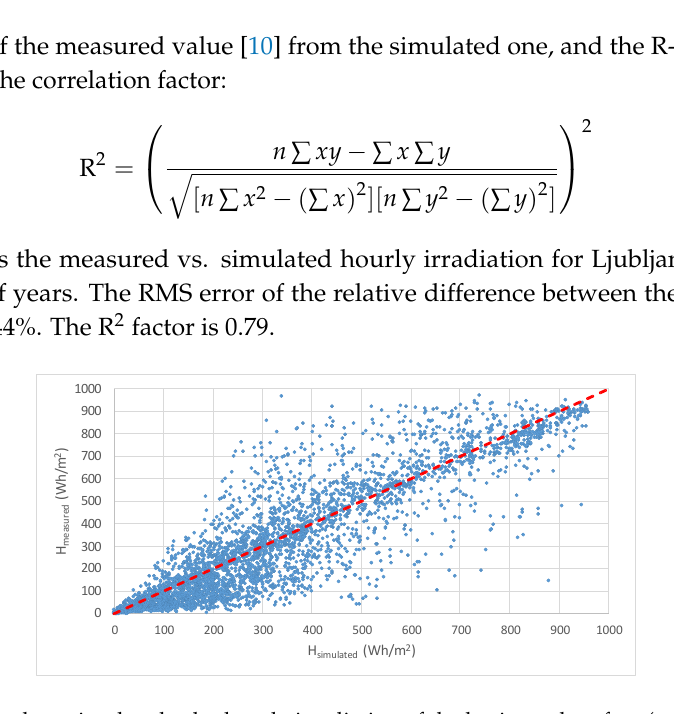
Figure 2. Measured vs. simulated solar hourly irradiation of the horizontal surface (red line is to guide your eyes and presents an ideal case).